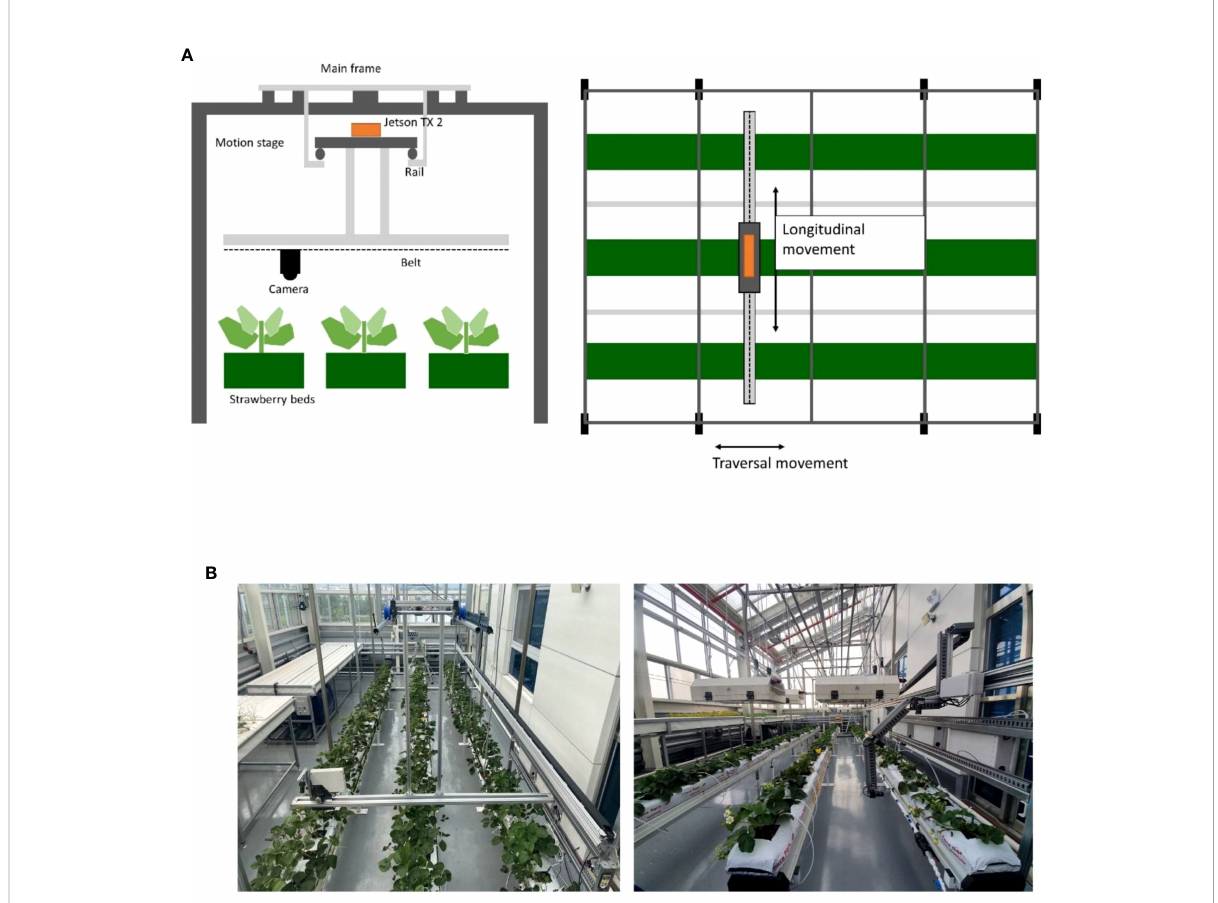
FIGURE 2 Overall information on the data acquisition system. (A) A vertical schematic of the system and a horizontal schematic of the system, (B) Actual view of the installed data acquisition system.